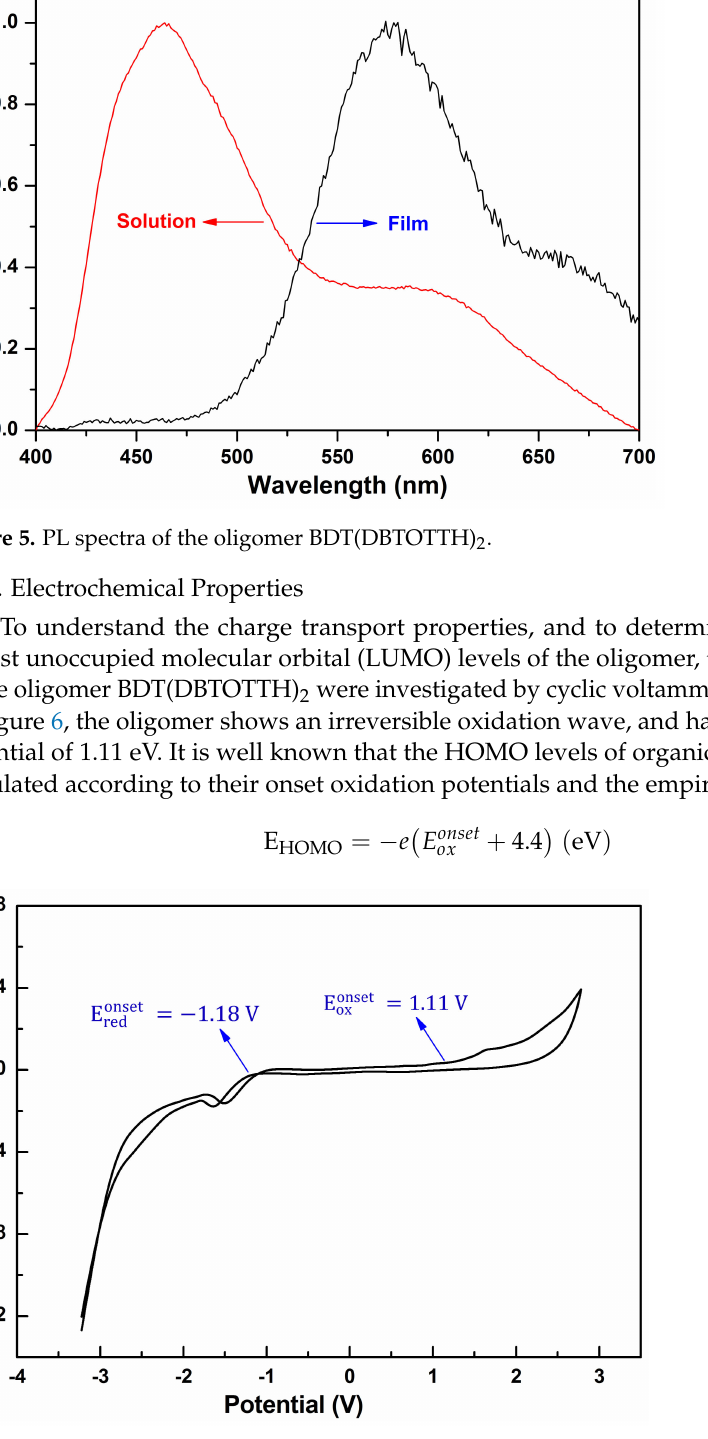
Figure 6. Cyclic voltammogram curve of the oligomer BDT(DBTOTTH) 2